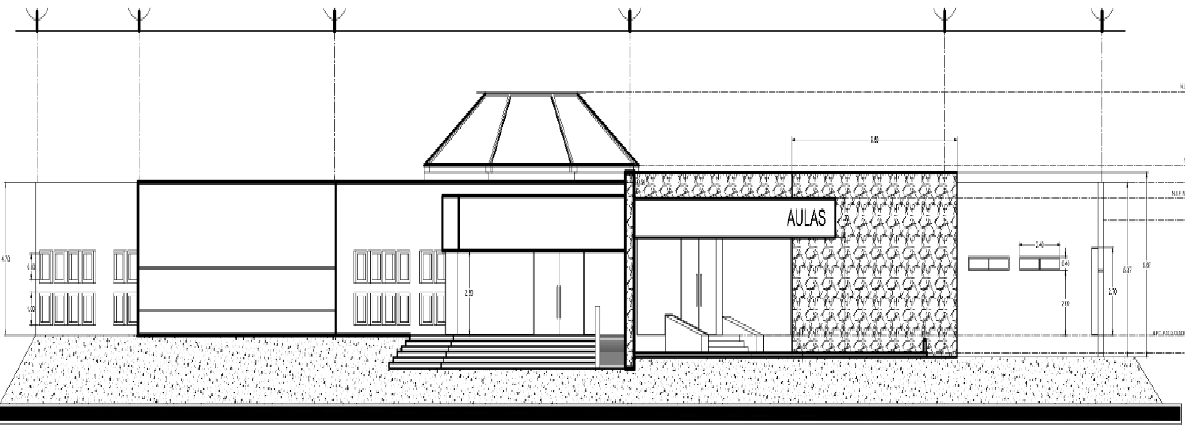
Figure 6, Student module Source Provided by the UICEH